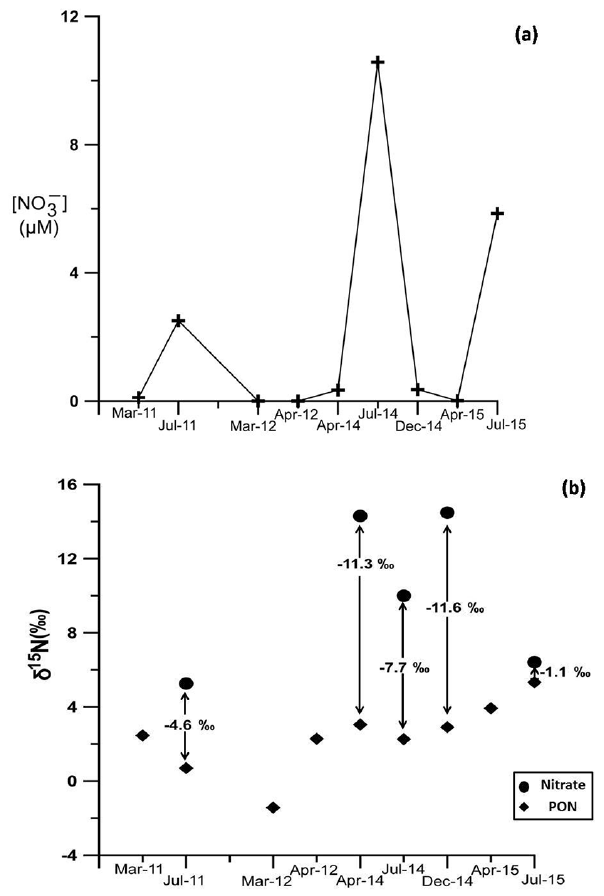
Figure 3. Time series of nitrate concentrations (a) and δ 15 N of dis- solved nitrate and POM in the epilimnion (0–5m) (b) . The isotopic differences between the dissolved and particulate species are de- noted by arrows. Each data point represents a single sample.